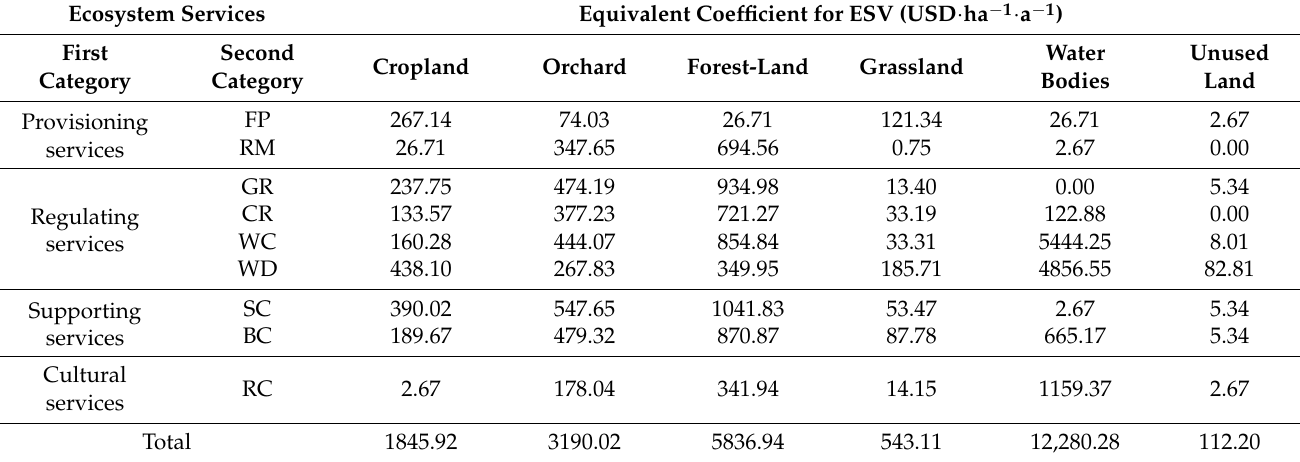
Table 2. The equivalent coefficient for the ESV of six land use types in